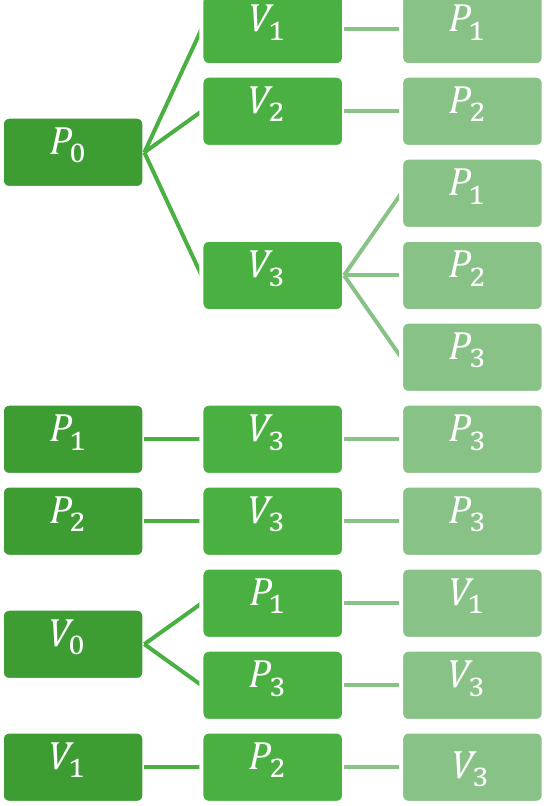
Figure 3. Diagram of possible transitions of plant and vector infections [21].